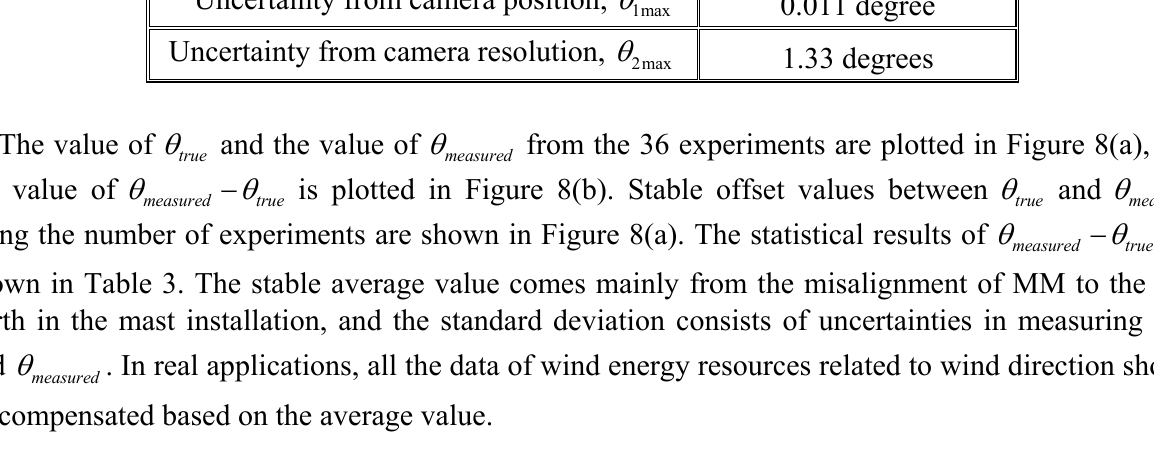
Figure 8. Experimental Result of